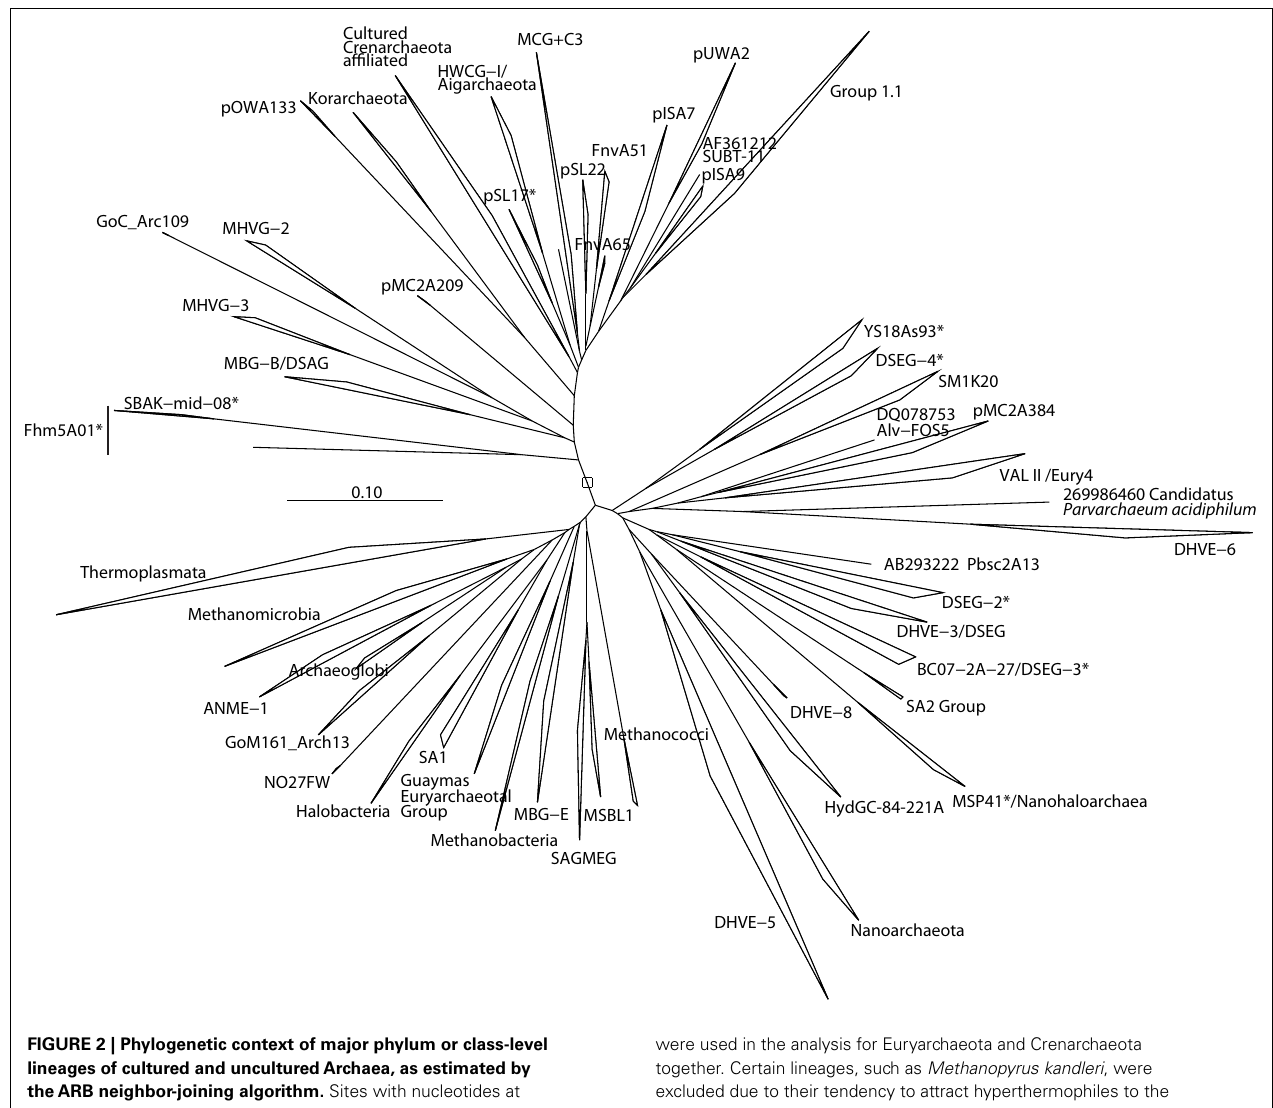
FIGURE 2 | Phylogenetic context of major phylum or class-level lineages of cultured and unculturedArchaea, as estimated by theARB neighbor-joining algorithm. Sites with nucleotides at least 60% conserved within all Euryarchaeota included in the tree